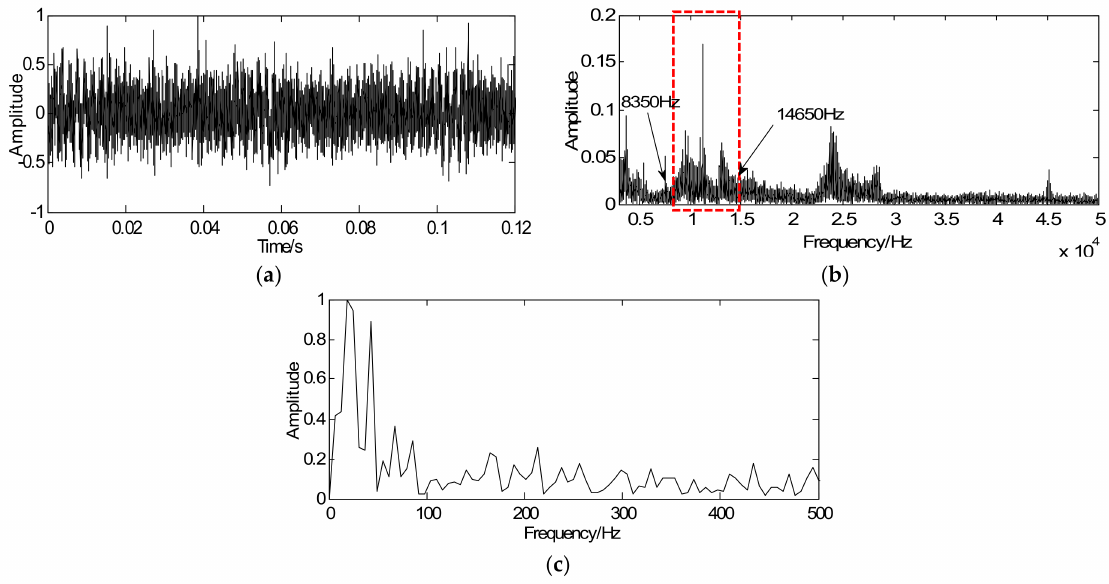
Figure 7. Bearing signals: ( a ) time-domain signal with outer-race fault, ( b ) spectrum of the time-domain signal, and ( c ) envelop spectrum of the time-domain